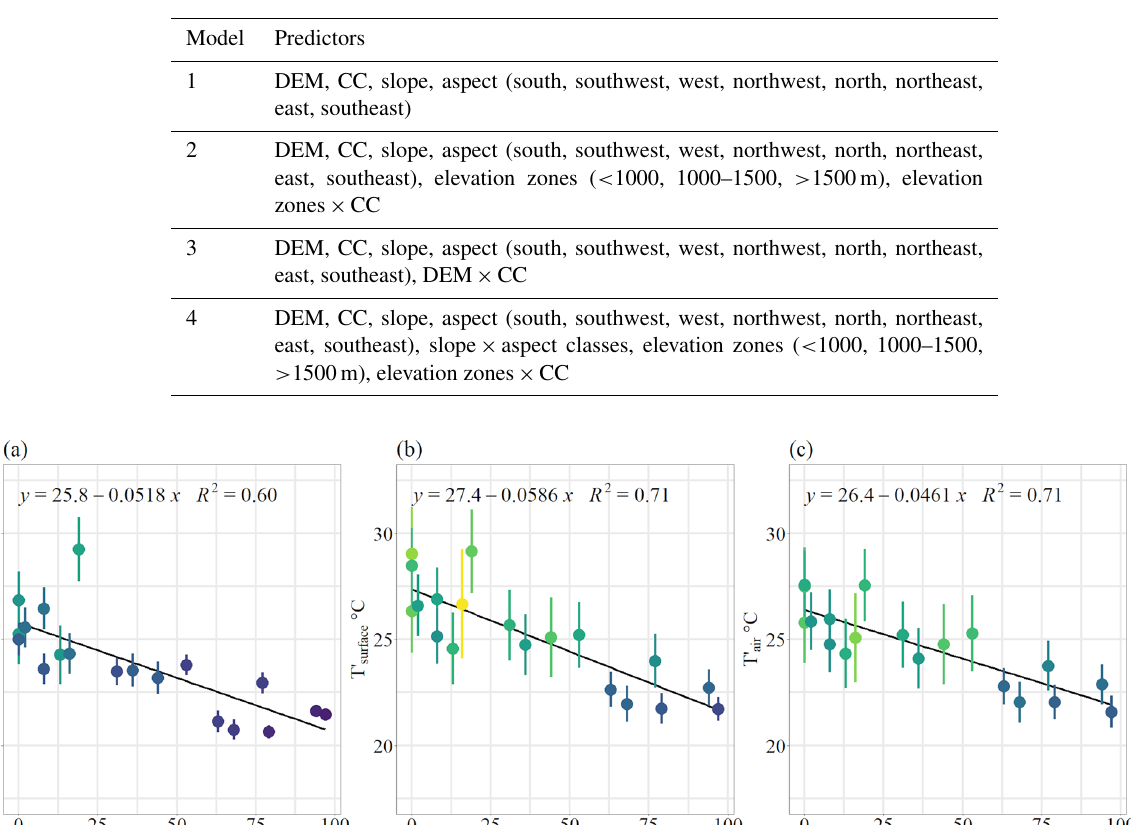
Table 2. Topographic and canopy cover (CC) predictors included in the four multiple regression models used in the analysis of Landsat 8 land surface temperature.